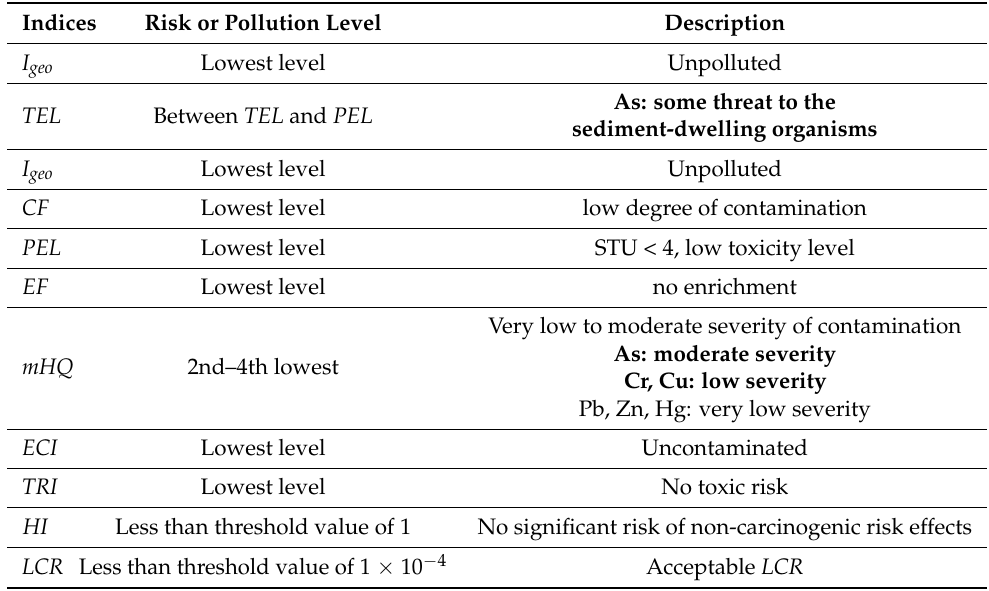
Table 8. Summary for different pollution or risk indices of heavy metals in sediment of Huaxi Reservoir in